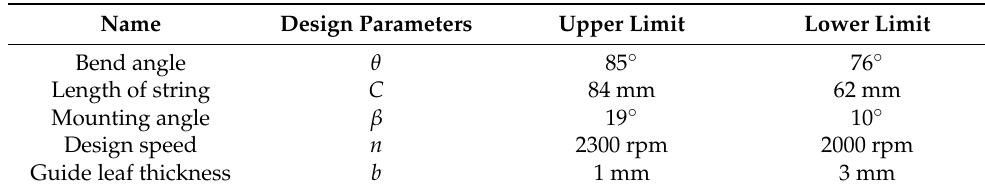
Table 1. The value range of design parameters.